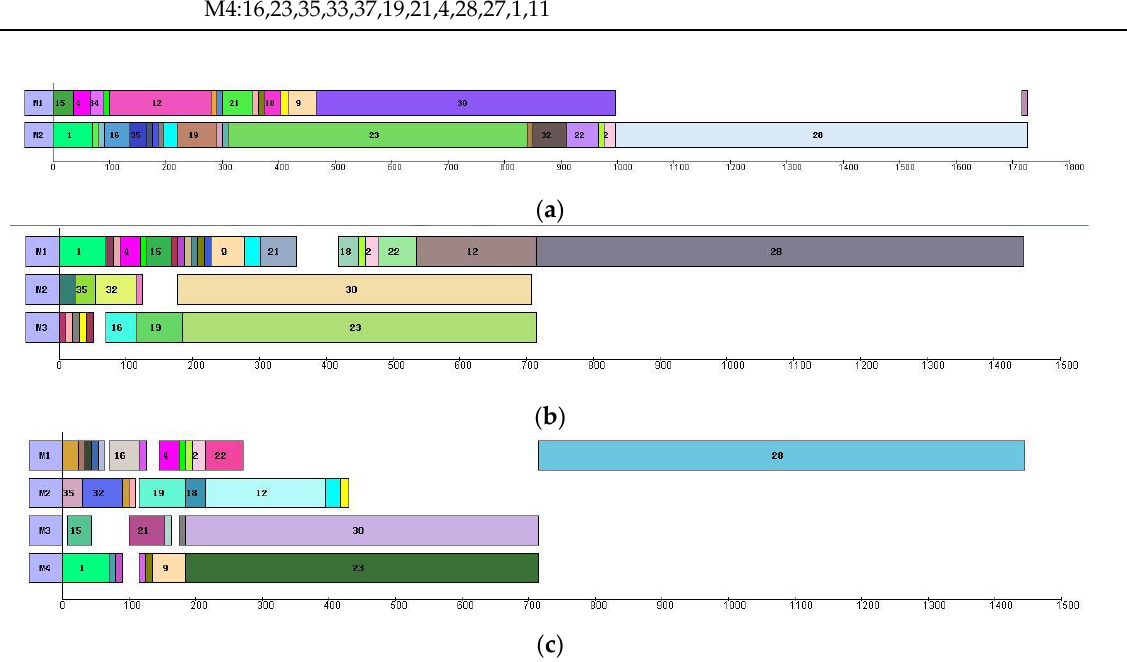
( c ) Figure 3. Gantt charts of Case 3 with 2–4 manipulators. ( a ) Case 3 with 2 manipulators ( C max = 1726). Figure 3. Gantt charts of Case 3 with 2 – 4 manipulators. ( a ) Case 3 with 2 manipulators ( max 1445 C = ( b ) Case 3 with 3 manipulators ( C max = 1445 ). ( c ) Case 3 with 4 manipulators ( C max = 1445 ). ( b ) Case 3 with 3 manipulators ( max ). ( c ) Case 3 with 4 manipulators ( m a x